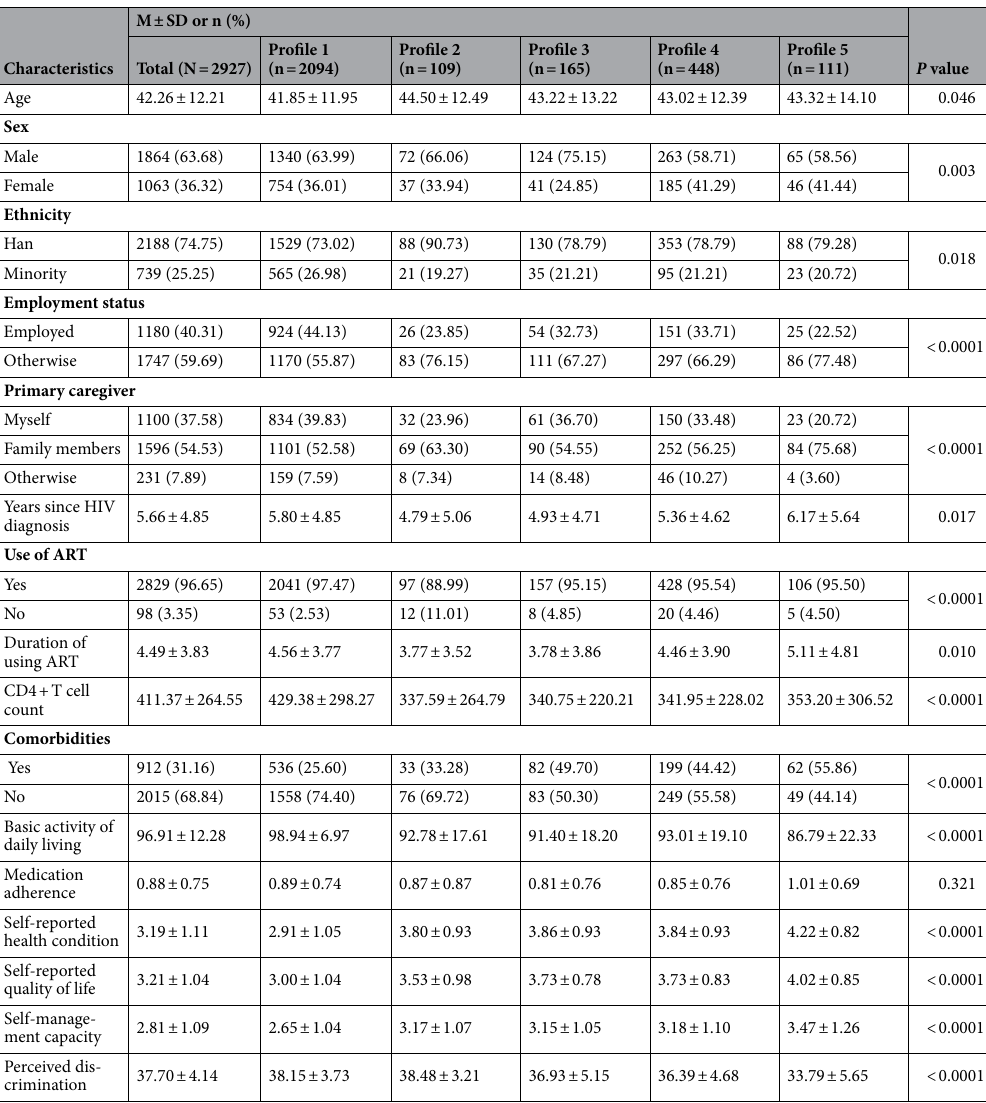
Table 2. Demographic and health-related characteristics difference among